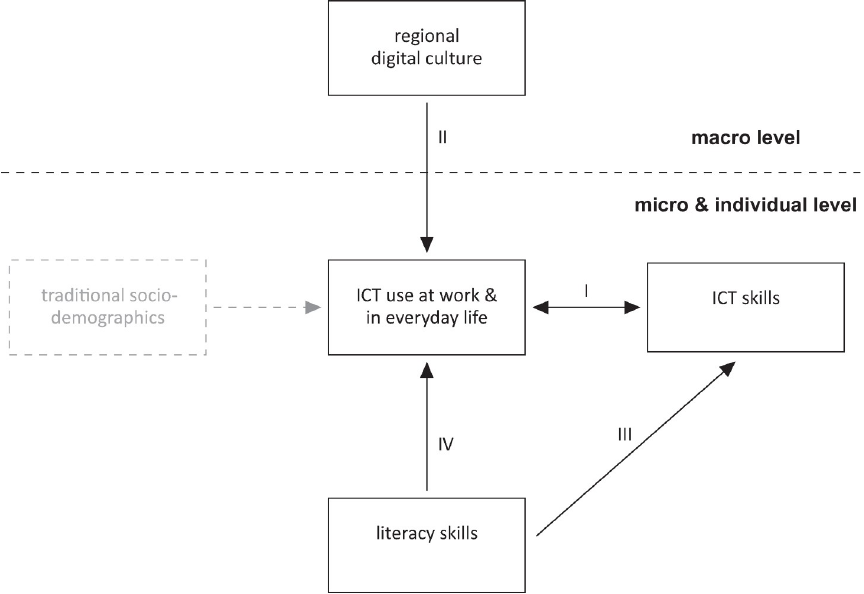
Fig 1. Conceptual framework identifying ICT use as a key prerequisite for the acquisition of ICT